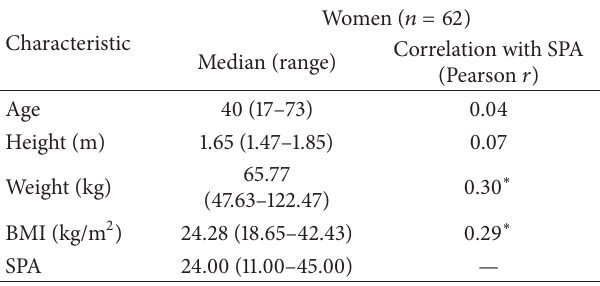
Table 4: Descriptive characteristics of injured participants. Table 5: Ratings for SPIRQ items and correlation with SPA for injured